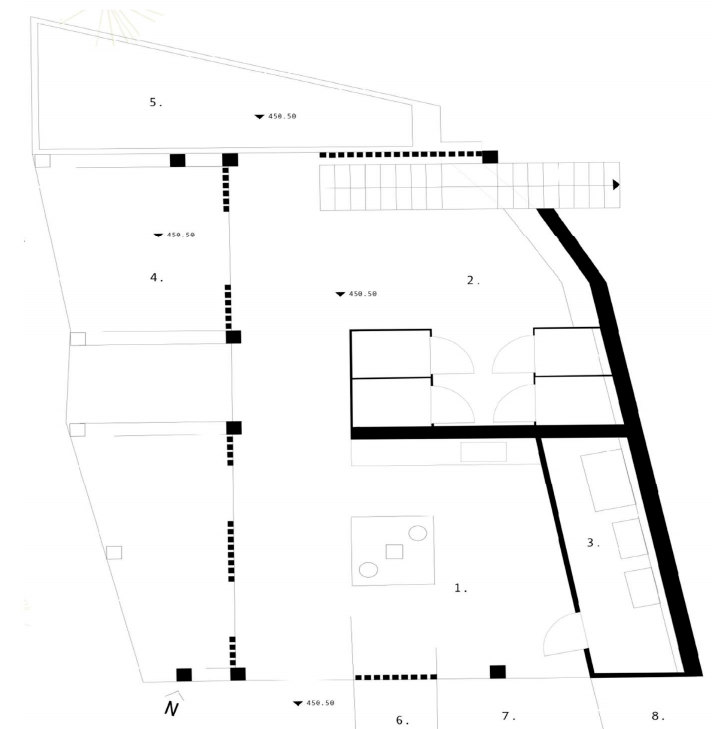
Figure 10. Tri Shala’s ground floor—the forest thicket. (1) kitchenette, (2) living room, (3) storage, (4) patio, (5) water purification pond, (6) shrub beds, (7) mulch, (8) ground (Source: compiled by the author).